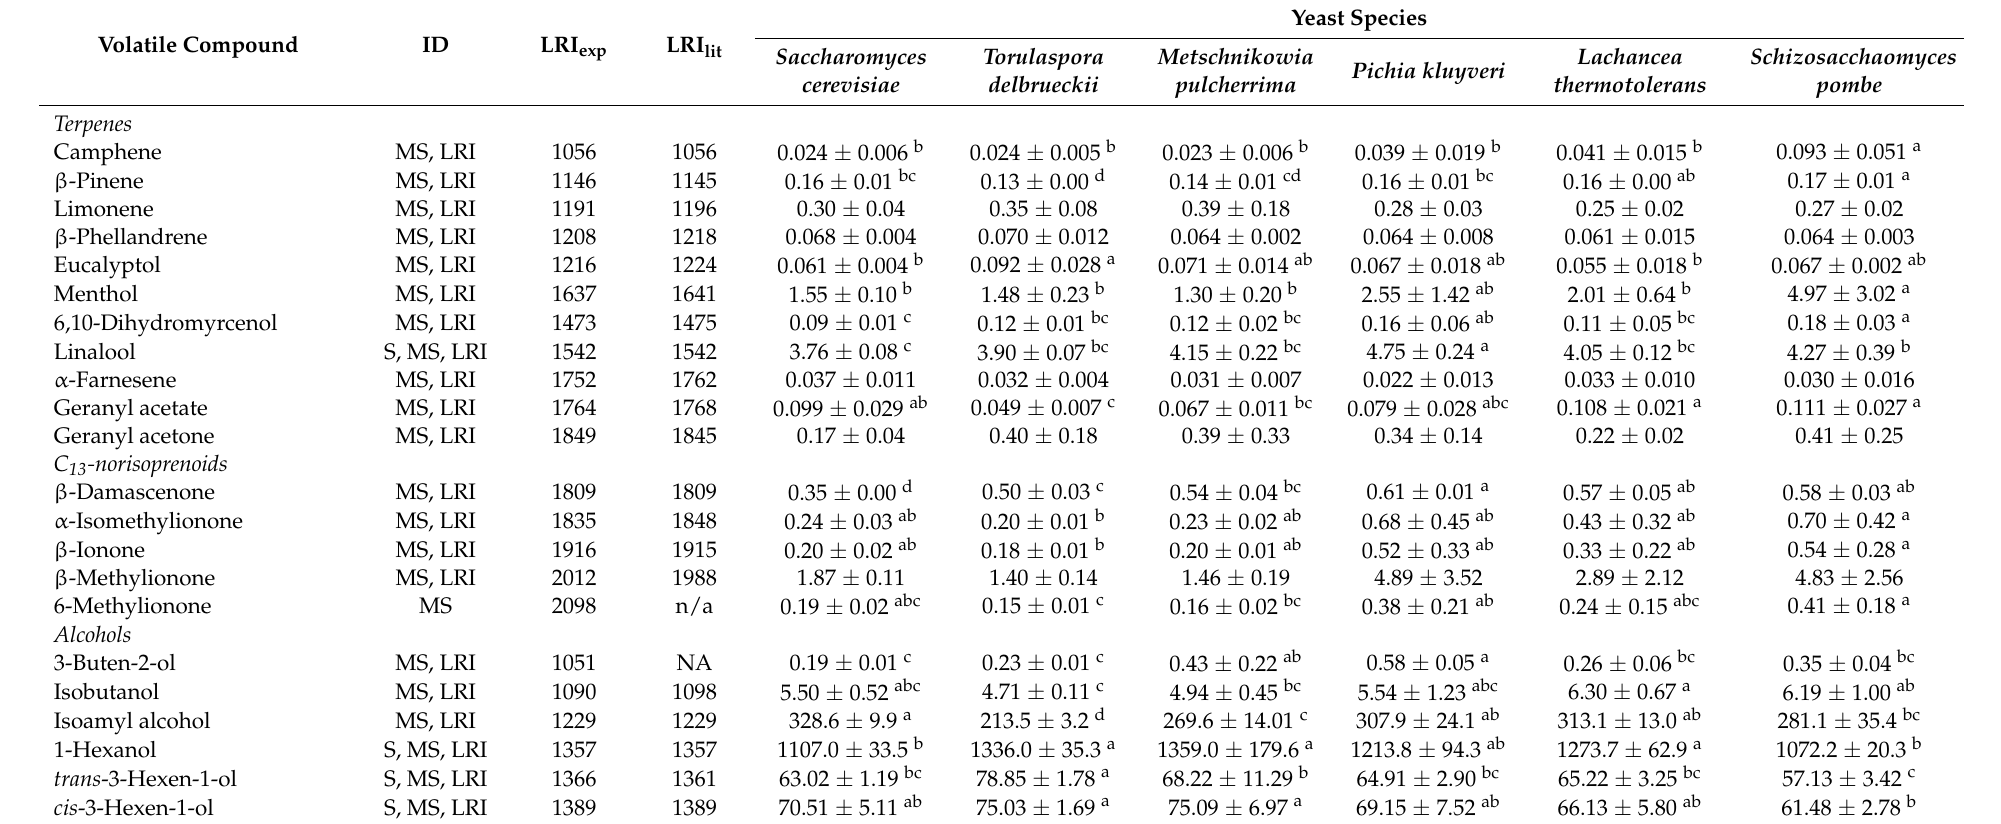
Table 1. Concentrations ( µ g/L)* of volatile aroma compounds identified in the early phase of fermentation of the Malvazija istarska grape must inoculated by Saccharomyces cerevisiae and five non- Saccharomyces yeasts obtained by headspace solid-phase microextraction and gas chromatography-mass